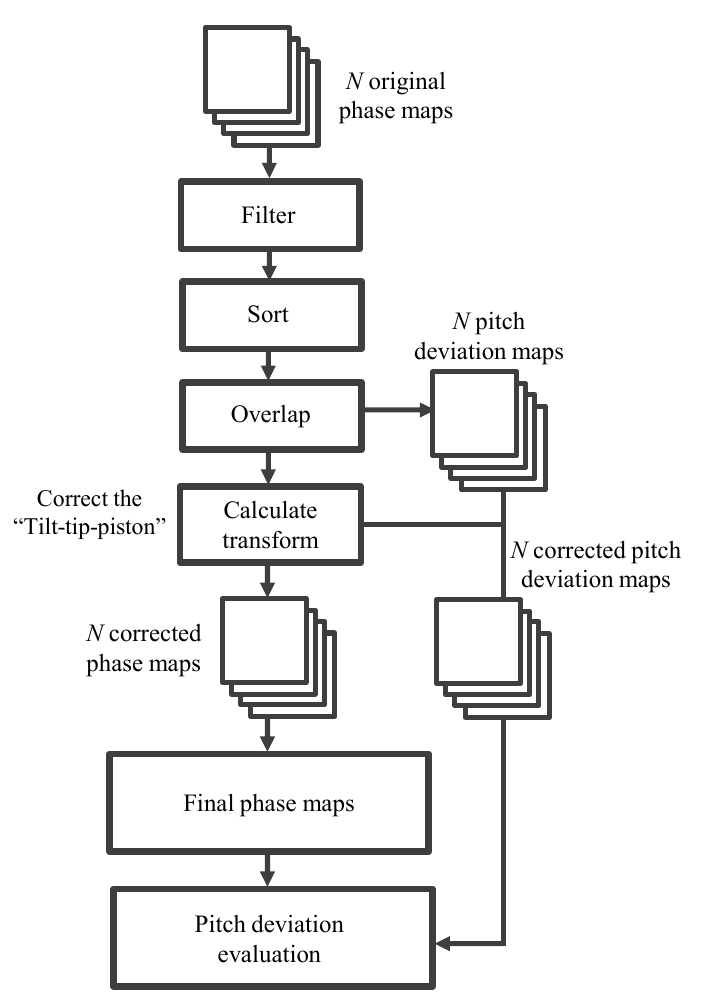
Figure 4. Flow diagram indicating the working principle and the data flow of the stitching algorithm for the calibration of the long-range linear scale pitch deviation.